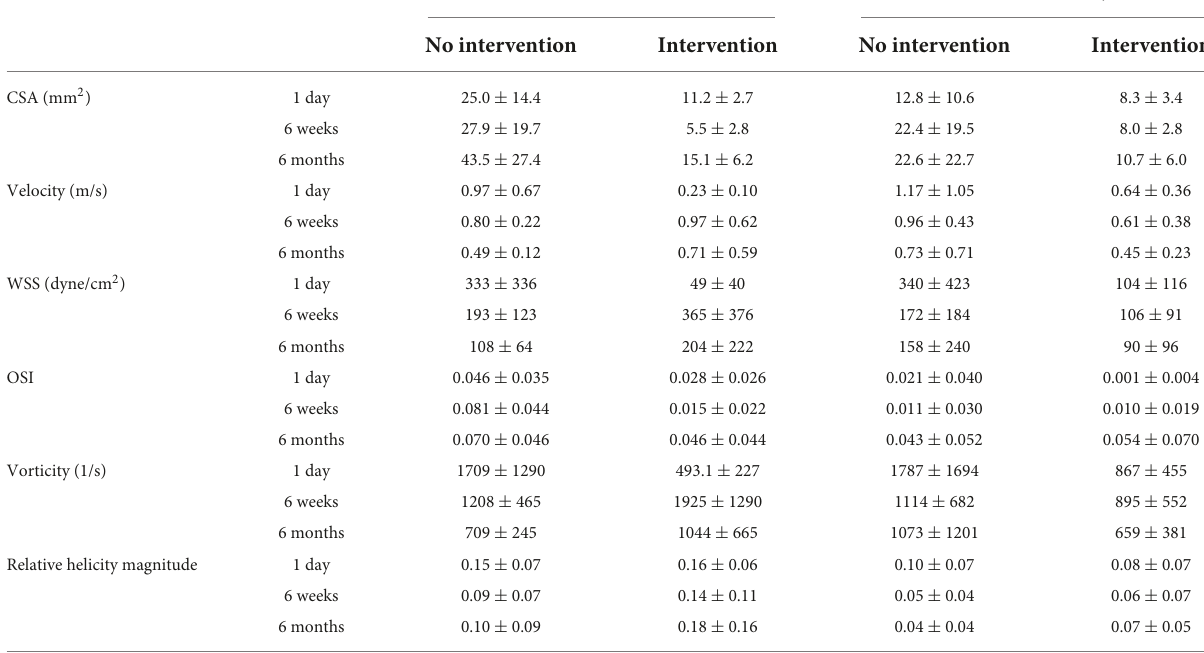
TABLE 2 Results of cross-sectional area (CSA), velocity, wall shear stress (WSS), oscillatory shear index (OSI), vorticity, and relative helicity magnitude. Proximal vein Proximal artery No intervention Intervention No intervention